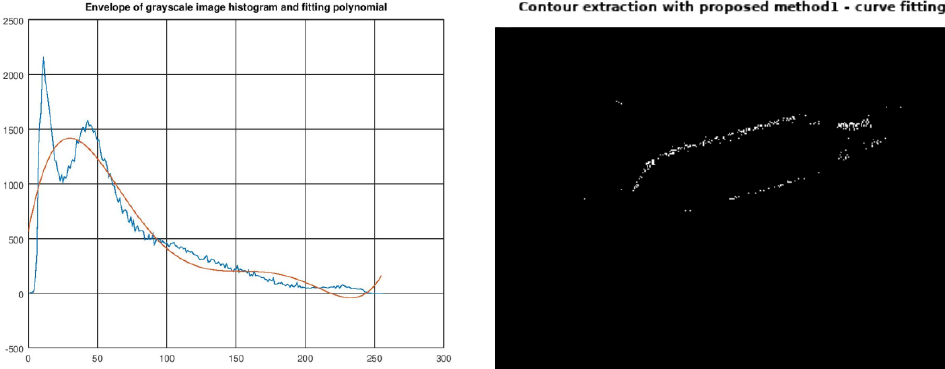
Figure 27. Bad threshold calculation due to poor fitting. On the other hand, high degree polynomials (such as n = 10 or 16) can achieve a better fit, but produce waveforms with a lot of fluctuation (overfitting). This results in multiple local minima (valleys), raising the problem of optimal valley selection. Valleys with small x values (e.g., around x = 180) fail to eliminate background noise, while valleys with large x values (close to x = 255) produce nearly black images. The latter case is demonstrated in Figure 28 for test image Frank Palmer. On the left we see the fitting polynomial of degree n = 6; on the right, the fitting polynomial of degree n = 16 which produces multiple valleys. The final valley produces a poor result (thin contour). Therefore, high degrees should be